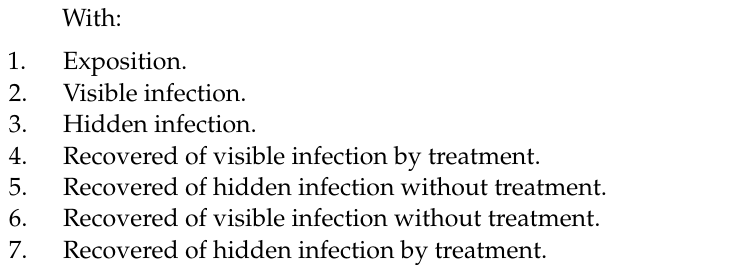
Figure 2. ABM—transfer diagram describing the COVID-19 dynamics in the